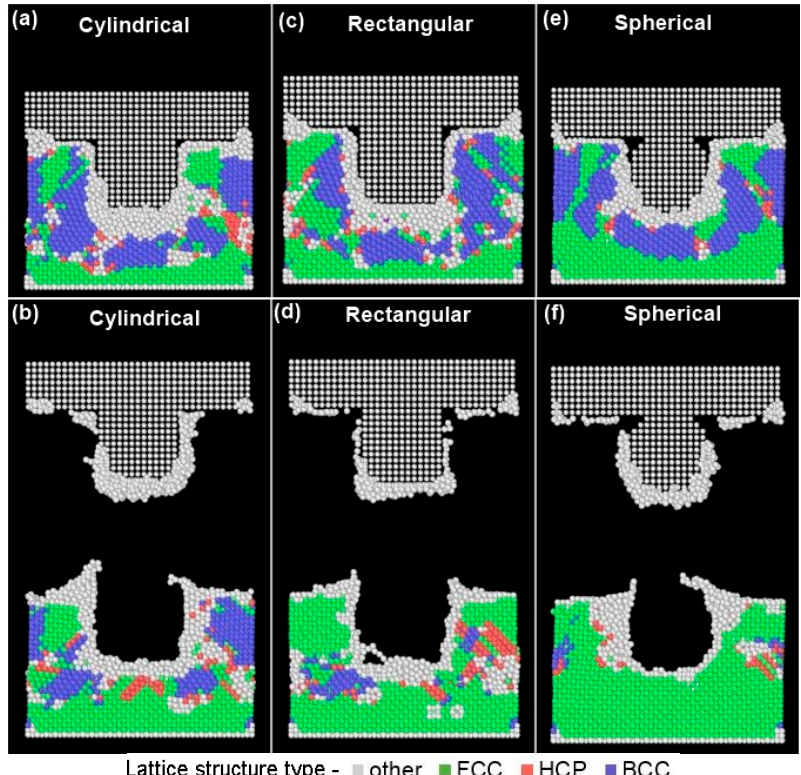
Figure 5. Lattice deformation behavior after molding (top row) and mold removal (bottom row) for different types of mold patterns. Time steps for ( a , c , e )—78,000; and ( b , d , f )—160,000.